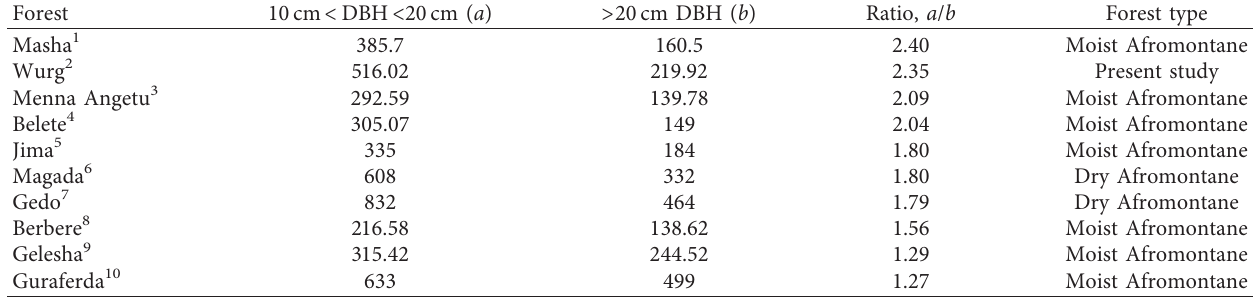
Table 5: Comparison of tree densities with DBH between 10 and 20, and > 20cm from Wurg forest with other Afromontane forests of Ethiopia.